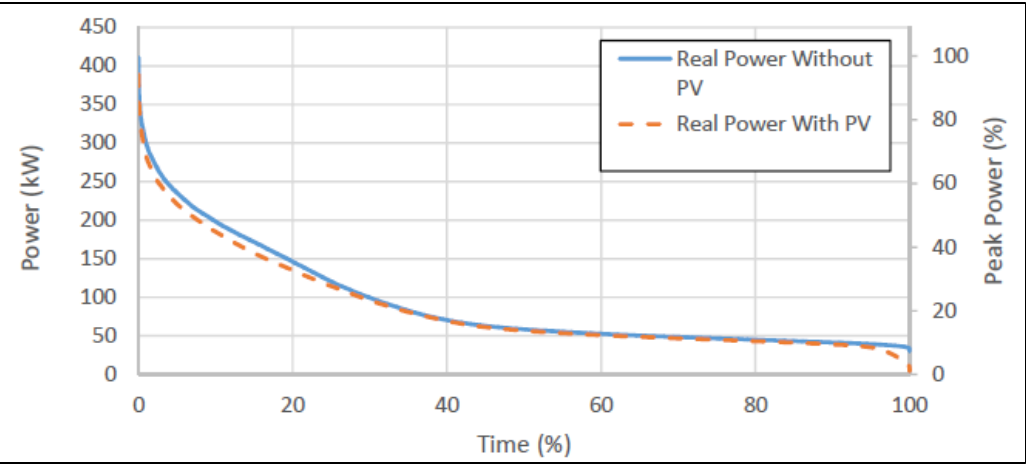
Figure 4. Effect of PVs on MCAST load demand.